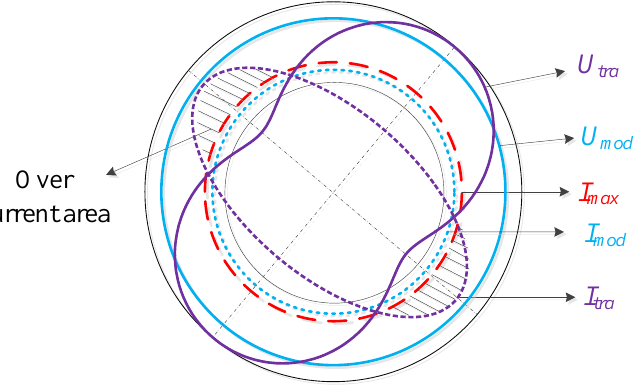
Figure 6. Change of voltage and current amplitude trajectories of the traditional and the modified topologies.